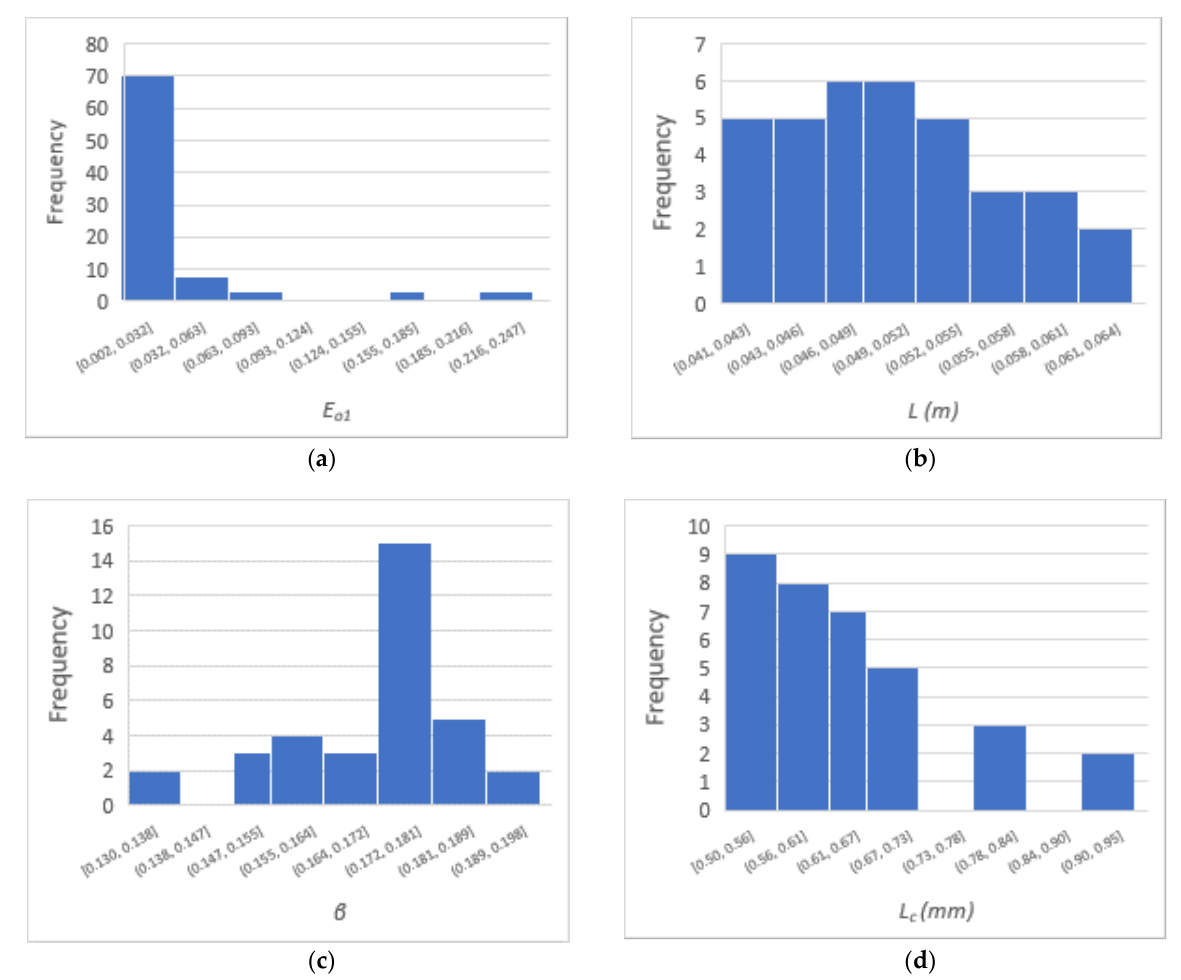
Table 4. Comparison of obtained result and required result.